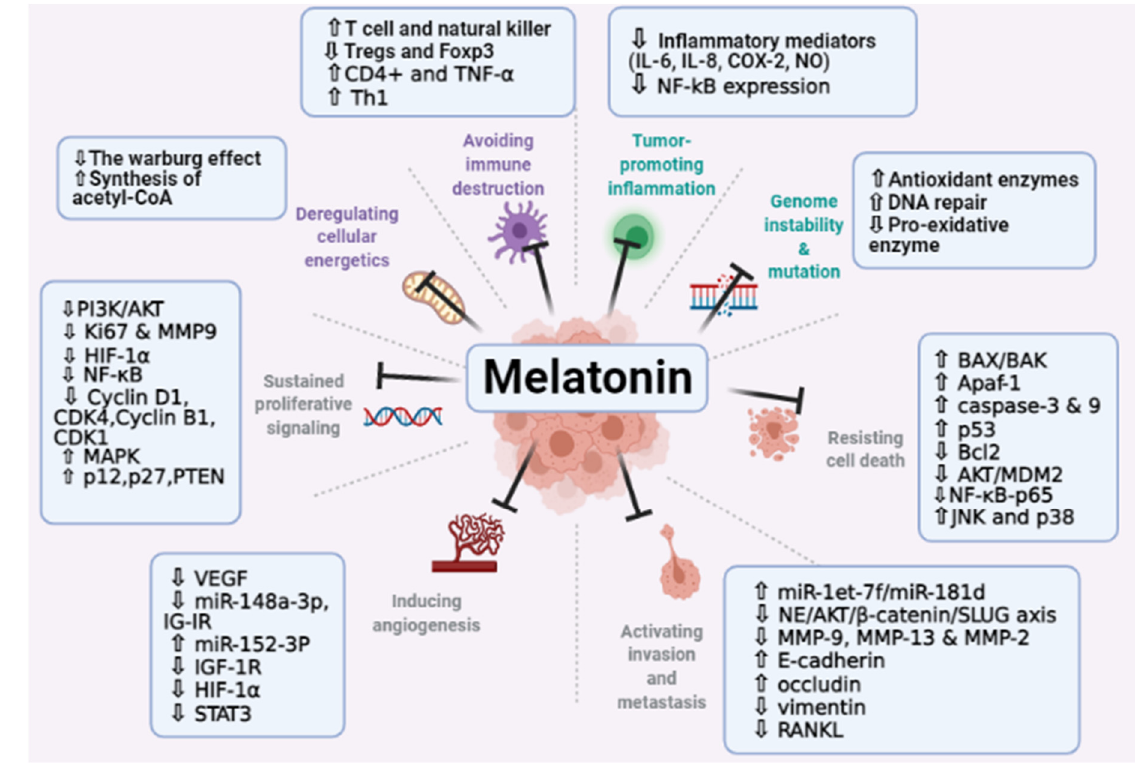
Figure 3. Summary of melatonin activity in restraining cancer hallmarks. BAX/BAK, proapoptotic proteins; NF- κ B, nuclear factor kappa B; JNK, c-Jun N-terminal kinase; VEGF, vascular endothelial growth factor; IGF-1R, insulin like growth factor 1 receptor; HIF-1 α , hypoxia-inducible factor 1-alpha; STAT3, signal transducer and activator of transcription 3; MAPK, mitogen-activated protein kinase; PTEN, phosphatase and tensin homolog.